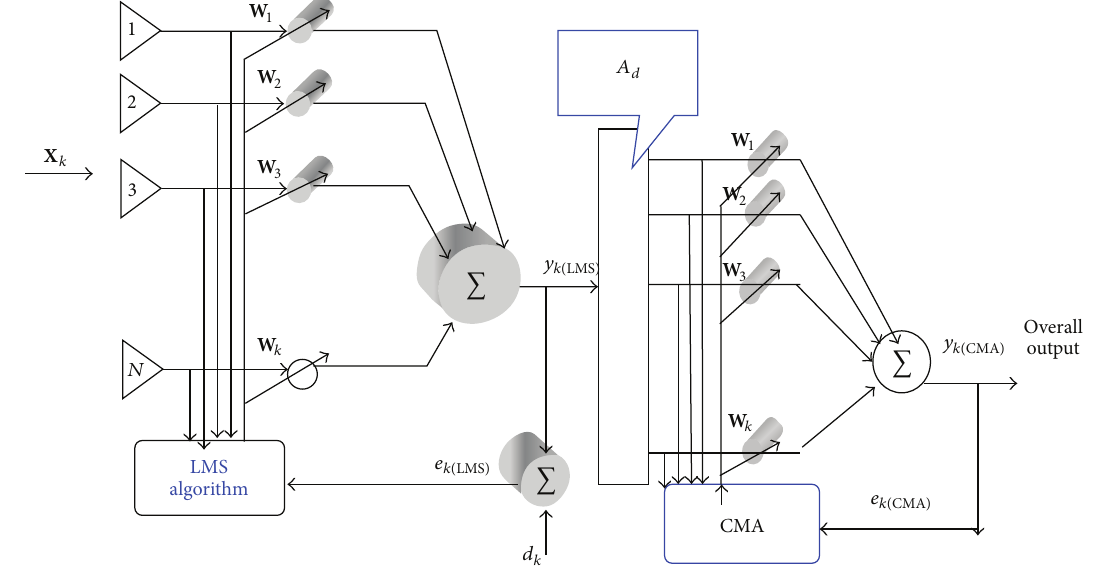
Figure 1: Proposed